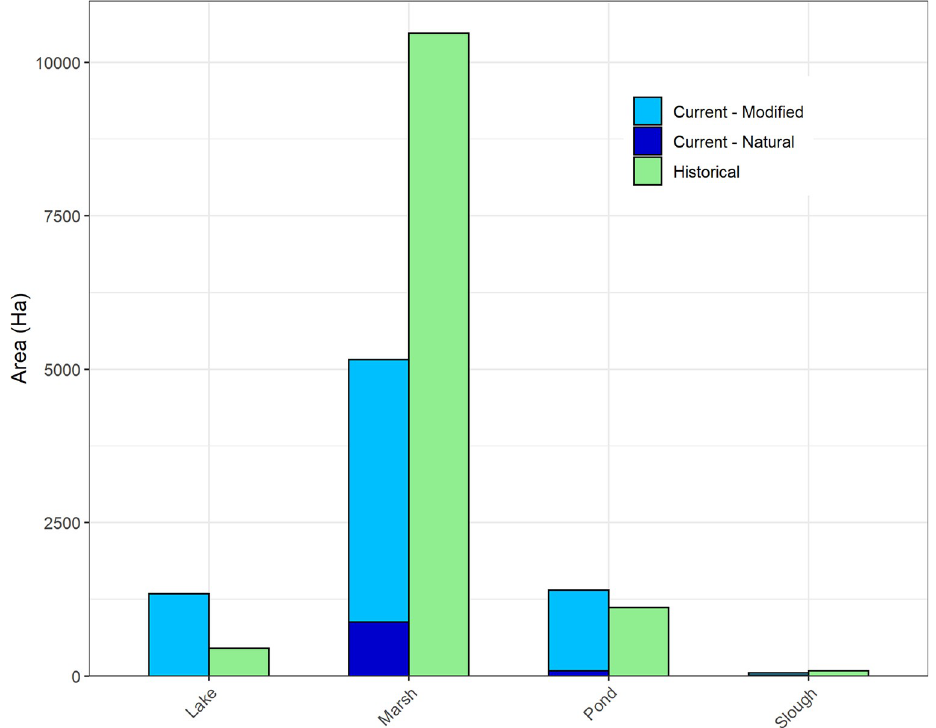
Fig 5. Floodplain habitat change. Area of floodplain habitat lost and gained (current floodplain area–natural potential floodplain area). Increases in lakes and ponds are due to constructed reservoirs, retention ponds, and other small impoundments.